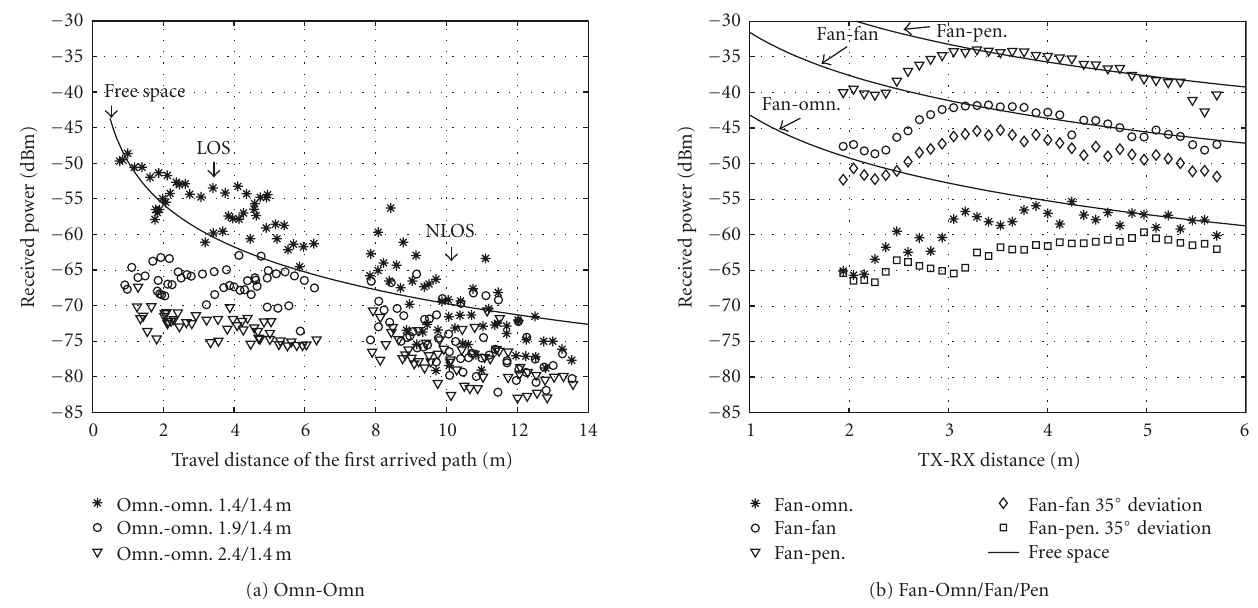
Figure 2: The received power over the travel distance of the first arrived path, when the transmit power is 0 dBm.